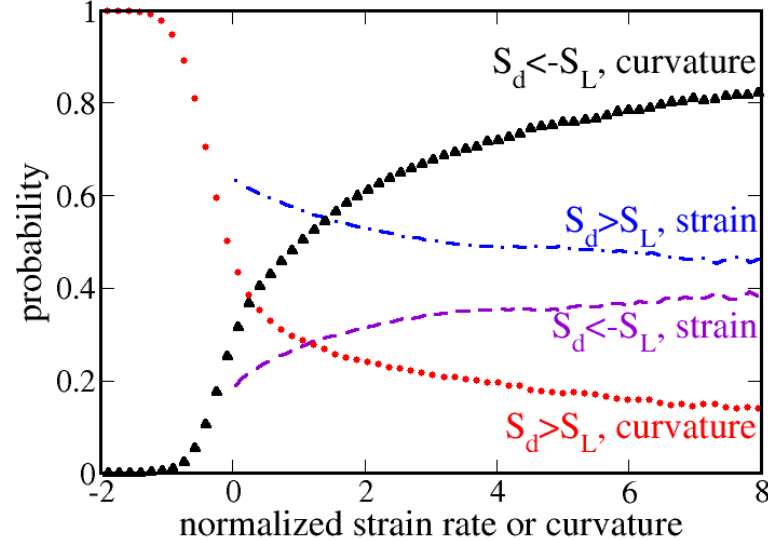
Figure 4. Probabilities of S d /S L < − 1 (violet dashed line and black triangles) and S d /S L > 1 (blue dotted-dashed line and red circles), conditioned to (i) the local curvature (symbols) h m of the reaction Figure 4. Probabilities of S d ⁄ S L < − 1 (violet dashed line and black triangles) and S d ⁄ S L > 1 (blue dotted- zone, normalized using δ F , or (ii) the local total strain (lines) S 2 normalized using (cid:104) ε (cid:105) /(2 ν ). Case TRW. dashed line and red circles), conditioned to (i) the local curvature (symbols) h m of the reaction zone, normalized using δ F , or (ii) the local total strain (lines) S 2 normalized using 〈 ε 〉 ⁄ (2 ν ). Case TRW. On the contrary, violet dashed or blue dotted-dashed line shows that the probability of On the contrary, violet dashed or blue dotted-dashed line shows that the probability of finding